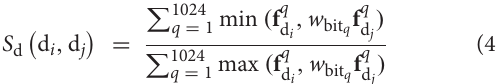
TABLE 1 | The statistics of two databases. Drugs Microbes